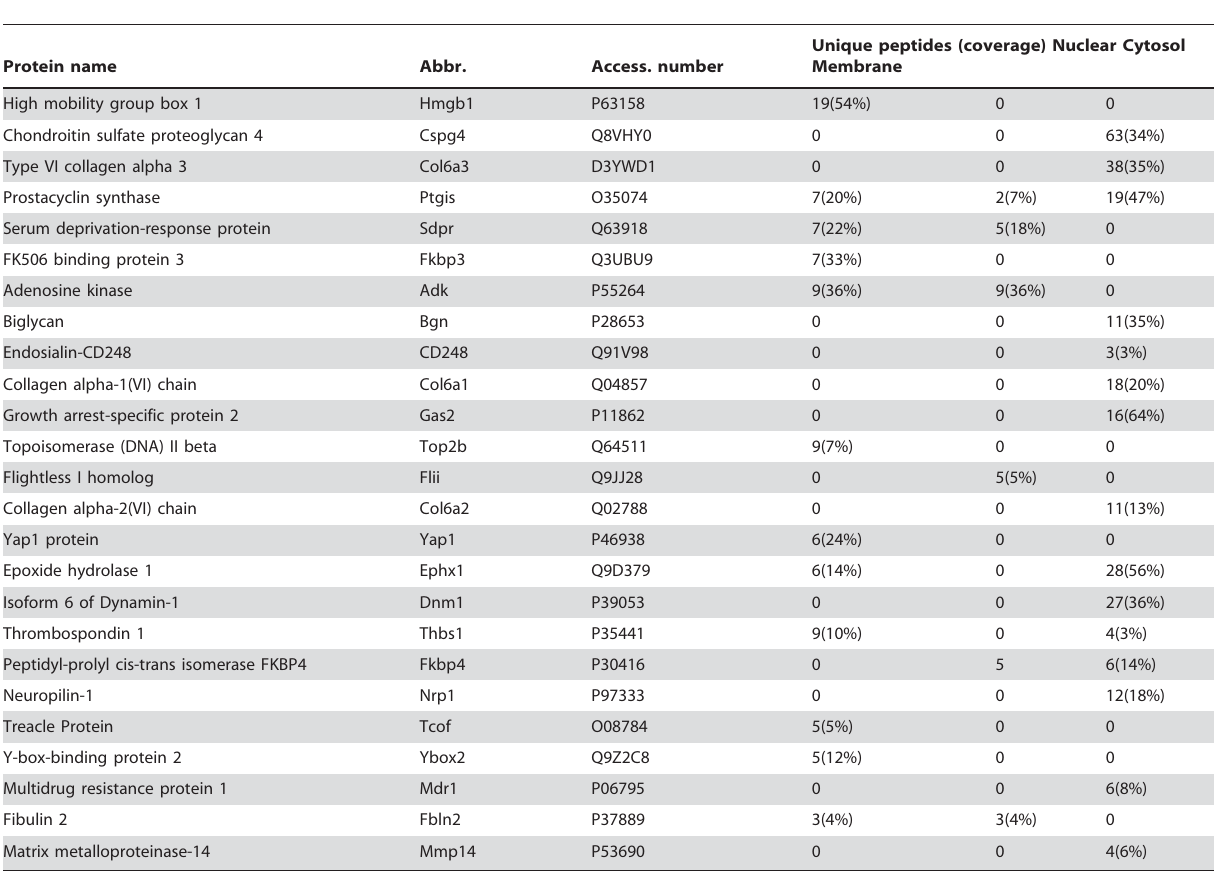
Proteins identified by LC MS/MS analysis of the nuclear, cytoplasmic and membrane subfractions of CD105 + cells were compared to those identified from CD105 2 cells in each of 3 replicate experiments. Unique proteins were sorted according to their Scaffold rank scores. The 25 highest ranking proteins are listed along with the number of unique peptides identified and percentage of protein coverage from a representative experiment (n=3). Also listed are the subcellular fractions from which each protein was consistently isolated in each of the three